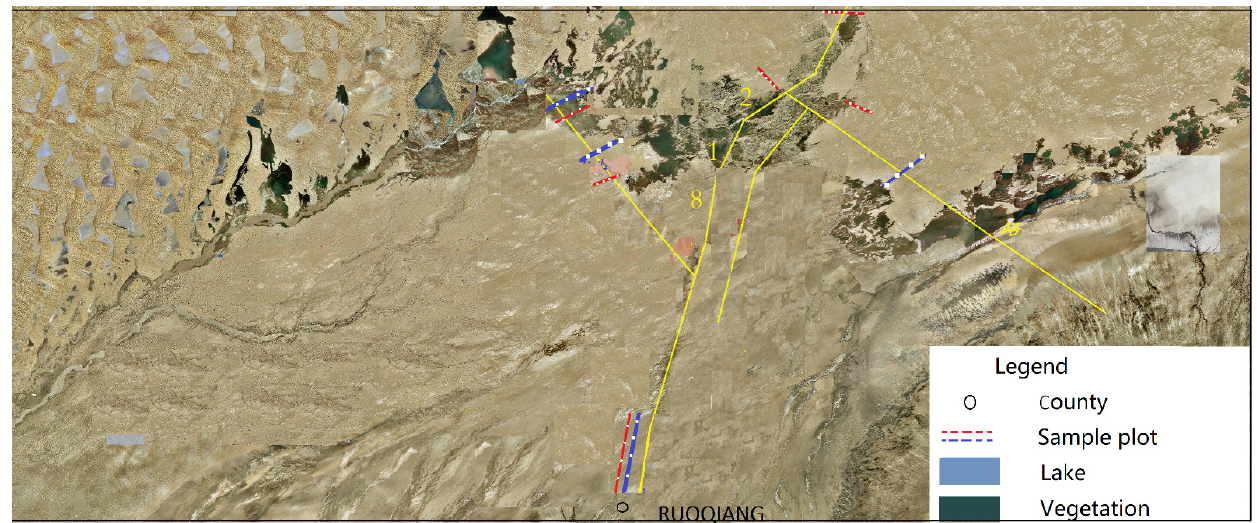
Figure 2. Geographical location of the monitoring